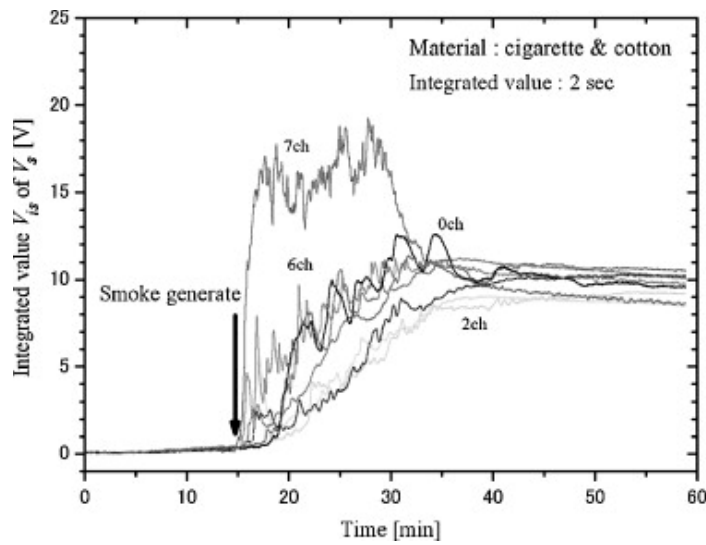
Figure 10. Integrated sensor signals (in 2-s windows) under smoldering fire condition. The dynamics of the gas plume are different for sensors located at different distances of the source. Shifted-temporal signal correlations between sensors placed at different locations are expected and they can be used to improve the prediction ability of the classification model. 7ch is the sensor closer to the source; 0ch is the sensor further from the source. The delay that corresponds to the time needed for the volatiles to reach sensors located further from the source is observed in the figure. Reproduced from [84].